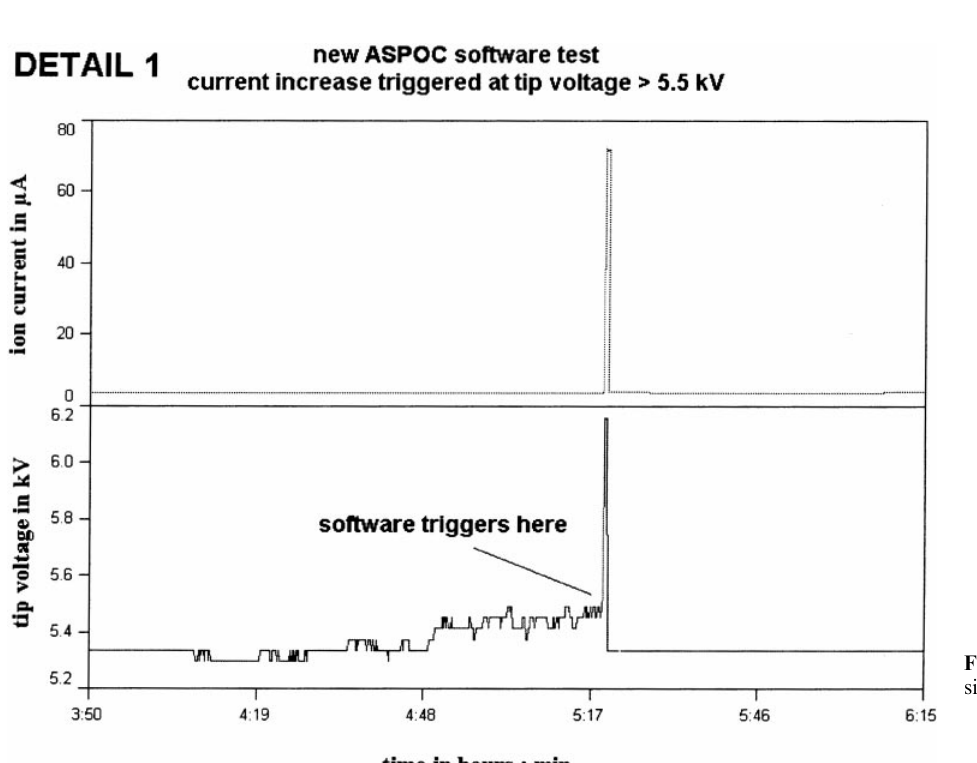
Fig. 5. Detail of Fig. 4 for a single cleaning cycle